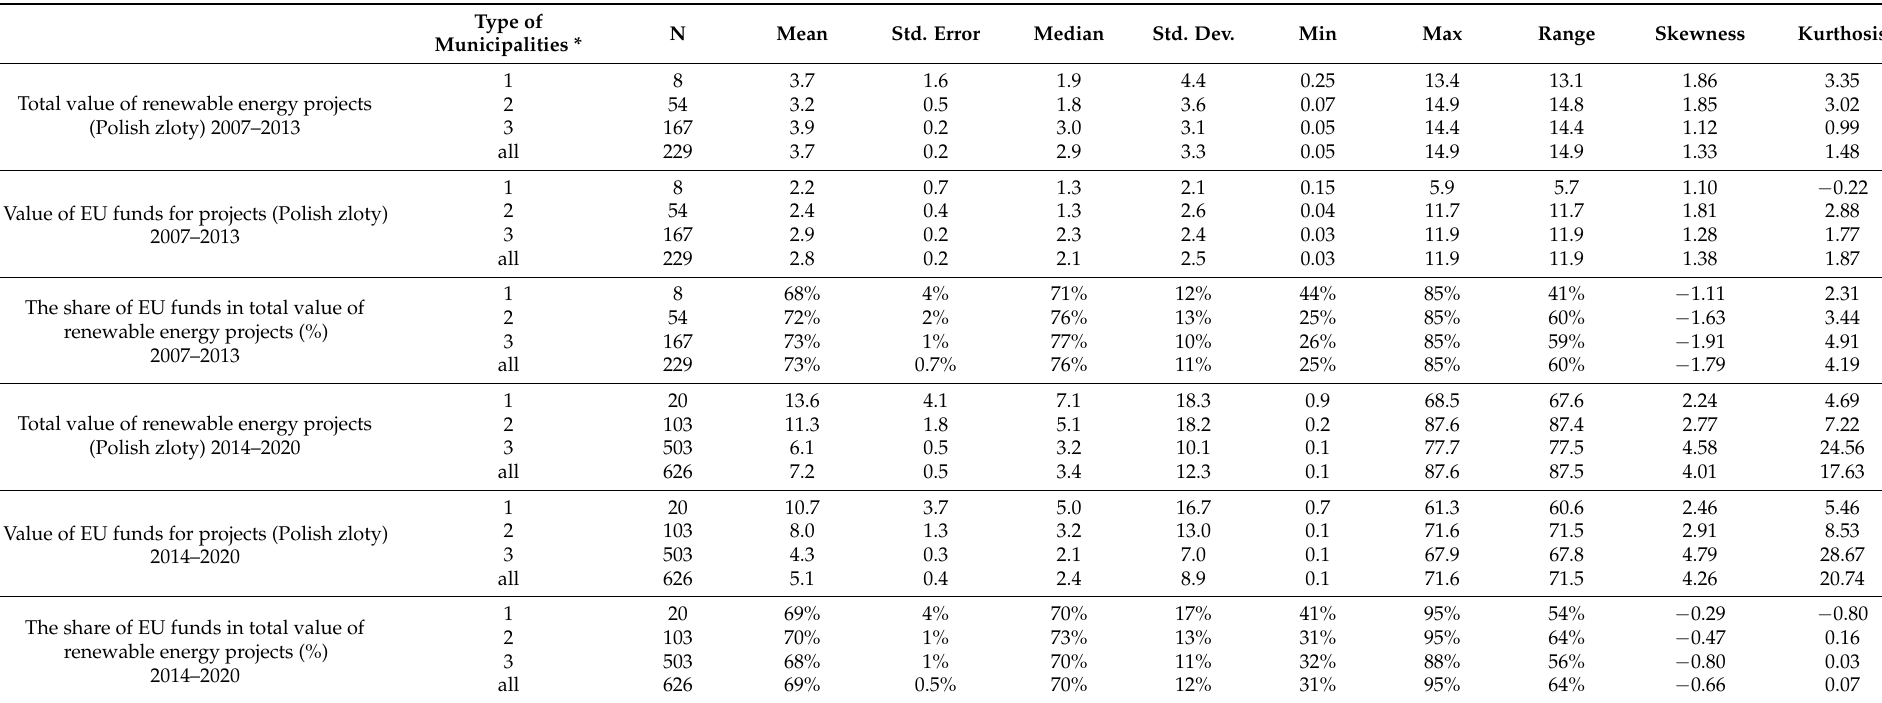
Table 4. Descriptive statistics for RE investments carried out by municipalities in Poland in 2007–2013 and 2014–2020 EU financial perspectives, by types of